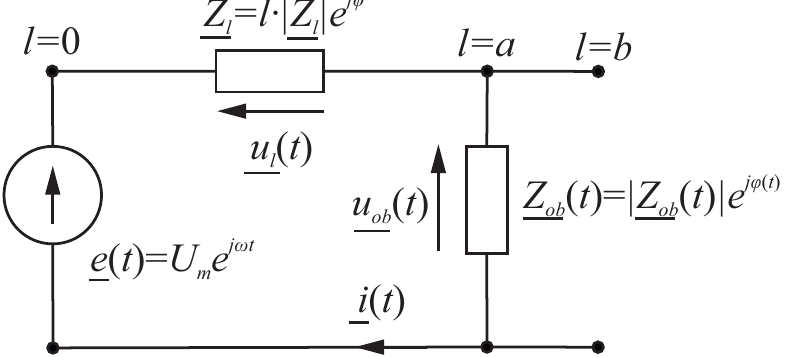
Figure 3. Diagram of a simplified single-phase power supply system for a disturbing load